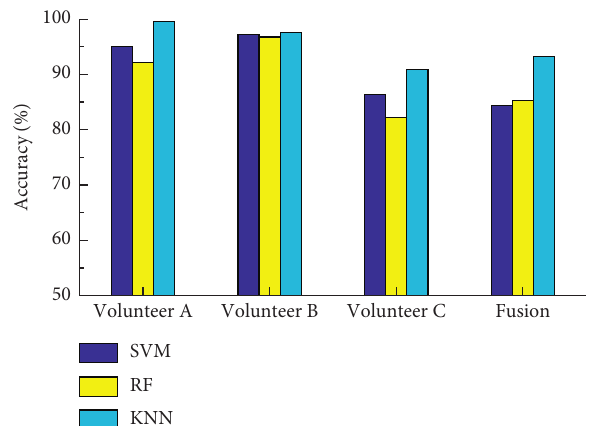
Figure 19: Comparison of the classifier indicators in the three approaches using RF classifier in an empty